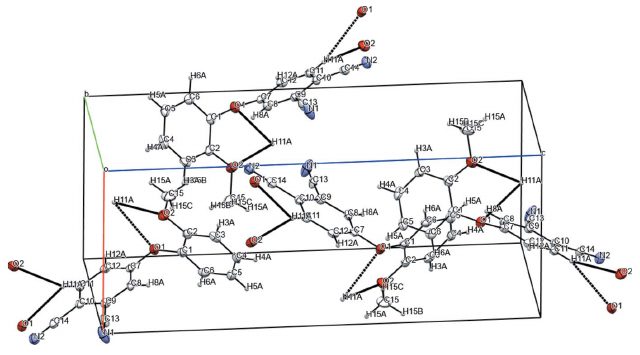
Figure 7 A view along the b axis of the crystal packing of m -4-(2-methoxyphen- oxy)phthalonitrile. Intermolecular hydrogen bonds have been removed for clarity.